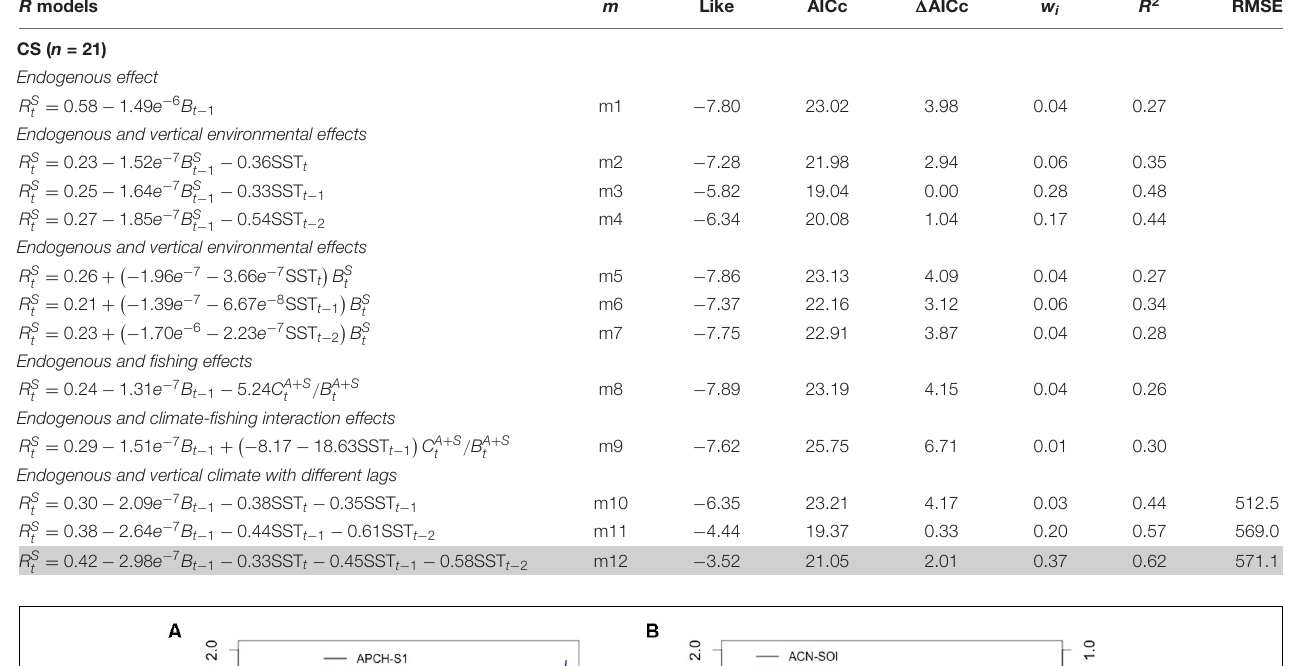
TABLE 3 | Population dynamics models for the common sardine ( Strangomera bentincki ) off central-southern Chile (33–41 ◦ LS). R models m Like